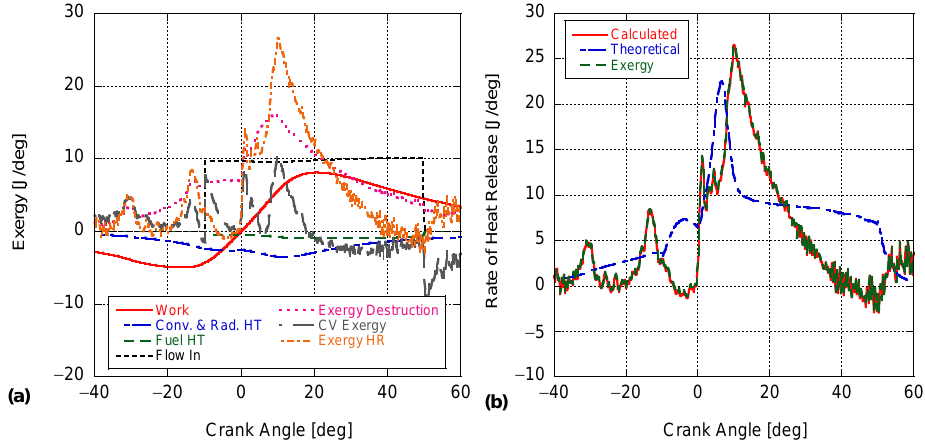
Figure 14. ( a ) Exergy components as a function of crank angle and the ( b ) rate of heat release for the first law and exergy equations.